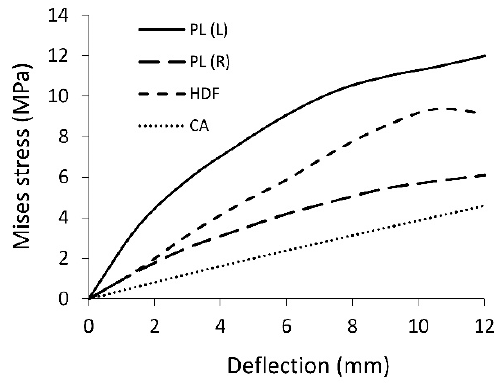
Figure 12. Mises stress at facing cracking point.